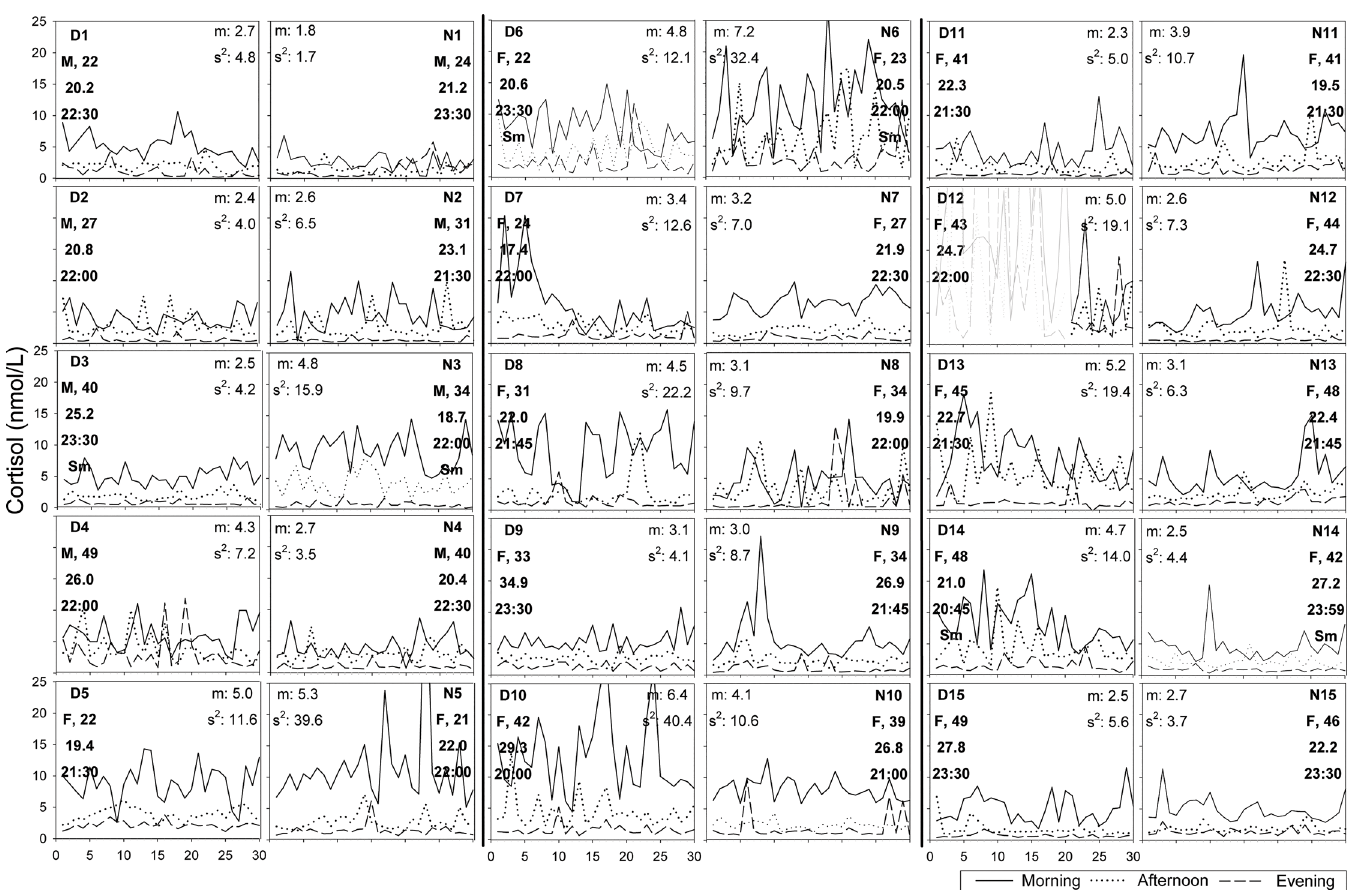
Fig 1. Cortisol patterns over 30 days stratified by beep-time (morning, afternoon and evening values). Graphs of pair-matched individuals are placed alongside each other (e.g. D1 and N1). In the corner of the graphs the following information is displayed: identification number (D = depressed, N = non- depressed), gender (F = female, M = male), age in years, BMI, evening beep-time, and, if smoking ‘ Sm ’ . Descriptive statistics at the opposite side of the graphs display m, the mean of the series and s 2 , the variance of the